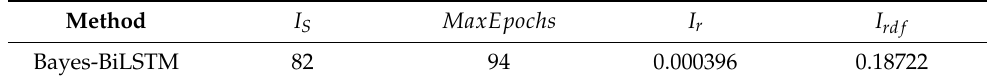
Table 5. Hyperparameter optimization results.